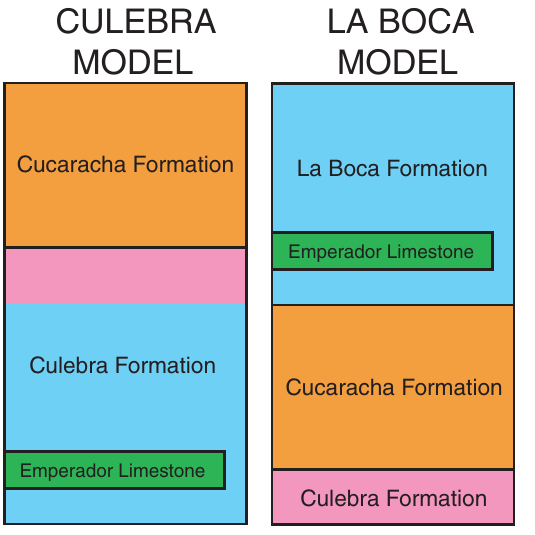
Figure 5. The two alternative stratigraphic models for the formations exposed along the Gaillard Cut portion of the Panama Canal: (1) the Culebra model [ 30,31,41 ] and (2) the La Boca model [ 27,44,45 ] . Equal color between the two models refer to the same stratigraphic unit.